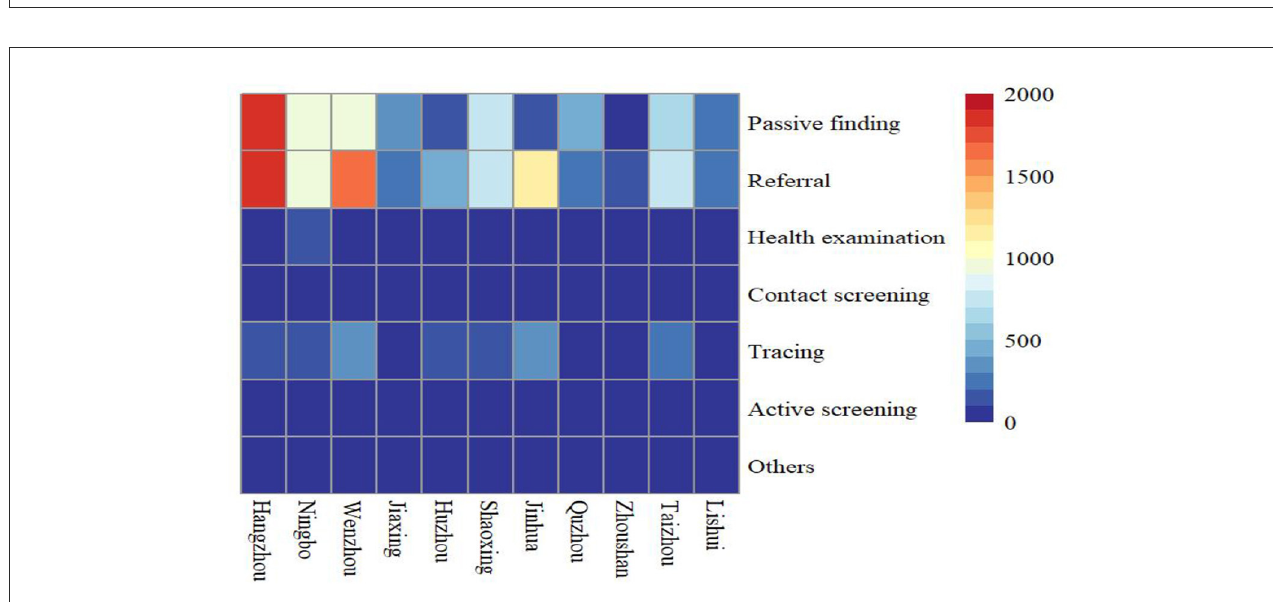
FIGURE2 Heatmap of patient sources in different cities from 2007 to 2020 (Different colors indicate different notified number of student PTB).